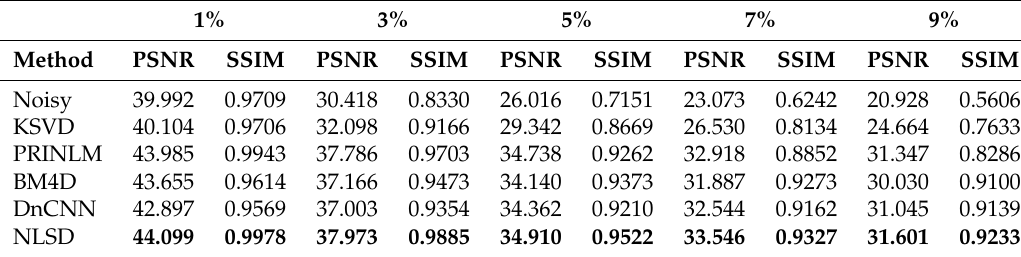
Figure 14. Residuals of the different results produced by the application of the methods evaluated on the noise-free T2w synthetic MR image of Figure 12a corrupted with 7% Rician noise. ( a – e ) are the denoising results of the methods KSVD, PRINLM, BM4D, DnCNN, and NLSD, respectively. ( f – j ) are the corresponding residuals. Table 2. Comparison of the different methods evaluated on the T2w synthetic noise-free MR image corrupted with different levels of Rician noise. Bold highlights indicate the best